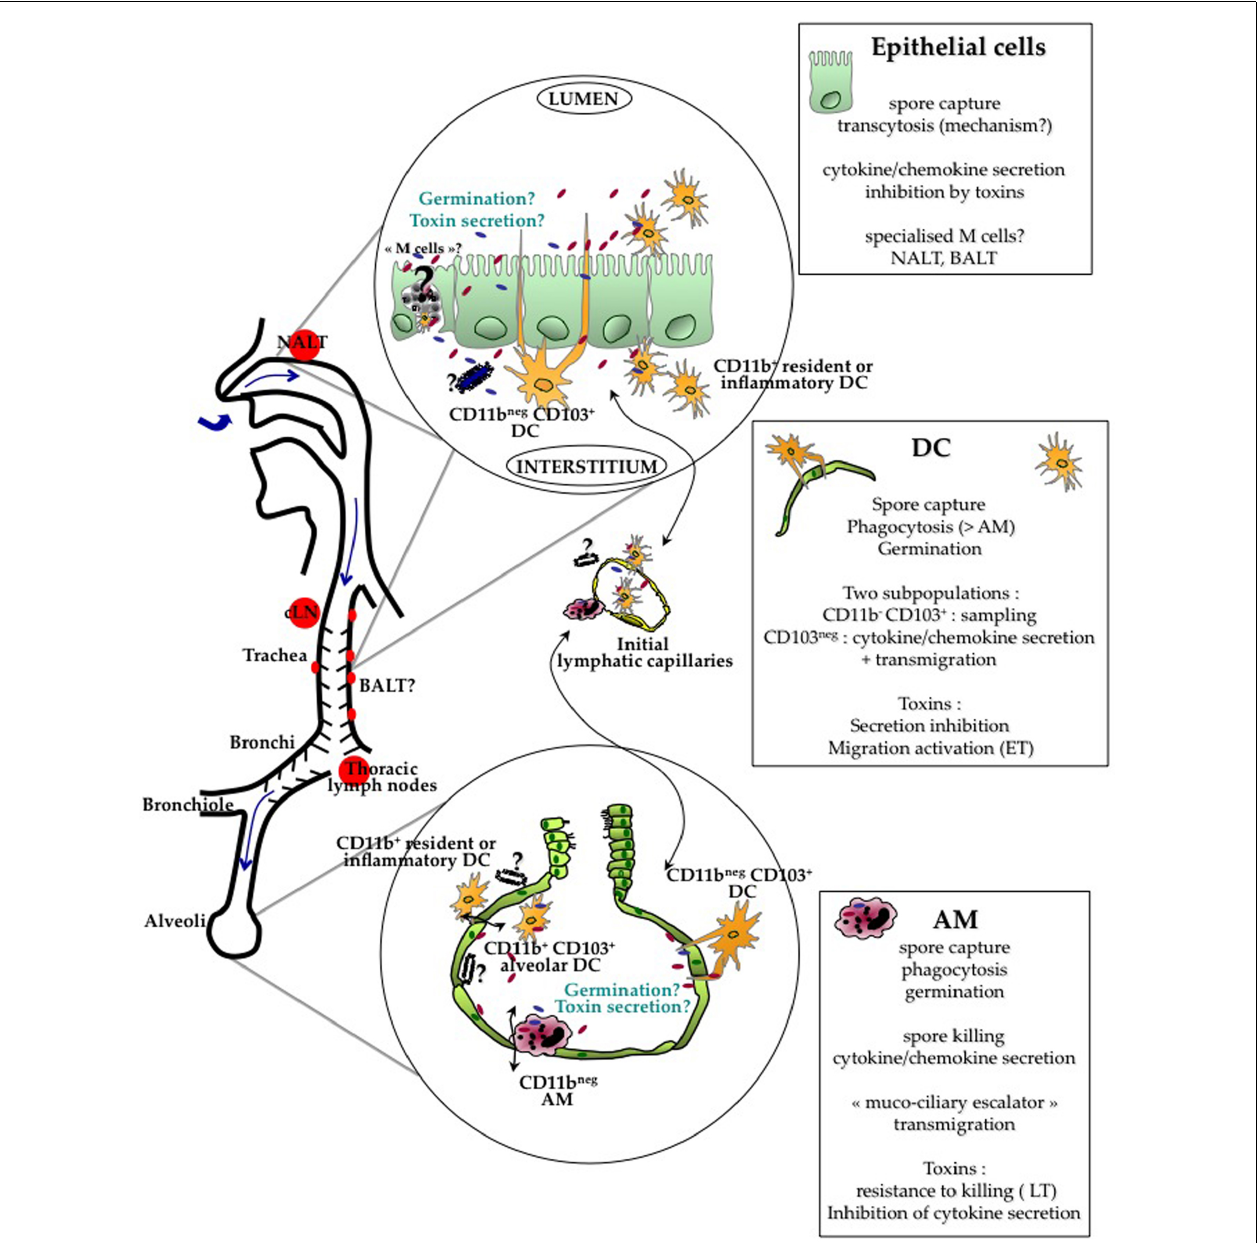
FIGURE 1 | Current evidence indicates that crossing of the respiratory barrier by the spores occurs all along the respiratory tract, from the nasopharynx to the alveoli. The type of cells involved in the crossing is probably different at these various locations. B. anthracis spores cross the respiratory epithelium through the help of different lung cells : alveolar macrophages (AM), dendritic cells (DC) and/or epithelial cells. Current data suggest that AM are able to relatively control and kill the bacteria. Intraepithelial CD11b neg CD103 + DC capture the spores through cytoplasmic extension sampling the respiratory tract lumen. Epithelial cells have been shown to internalize spores and support transcytosis through still unknown mechanisms; the involvement of specialized epithelial M cells located in the epithelium overlying the lymphoid follicles over the NALT and BALT is still unknown. Spore interactions with all these cells lead to cytokine/chemokine secretion. Monocytes, DC and neutrophils are rapidly recruited in the alveolar lumen, contributing to local cytokine secretion and epithelial transmigration. Evidence suggests that germination occurs at a limited level in the respiratory tract. In simplified cellular models using AM, DC and epithelial cells, toxins globally inhibit the innate response. A key point still to be clarified is whether toxin secretion, either on the apical or the basolateral side of the epithelium positively affects epithelium crossing and further dissemination. Relative distribution of the toxin receptors on both sides is still largely unknown as well the number of spores that are required to cross the epithelium to establish a successful infection. A very low efficiency in epithelium crossing might be balanced by a high survival rate after the crossing steps. After crossing, DC and AM enter the button-like ends of the initial lymphatic capillaries and migrate into the draining lymph nodes, cervical or thoracic lymph nodes depending on the site of entry. If encapsulated bacilli or spores reach the basolateral side, migration as free bacteria into the lymphatics may also occur due to the Starling forces present in the interstitial tissue.